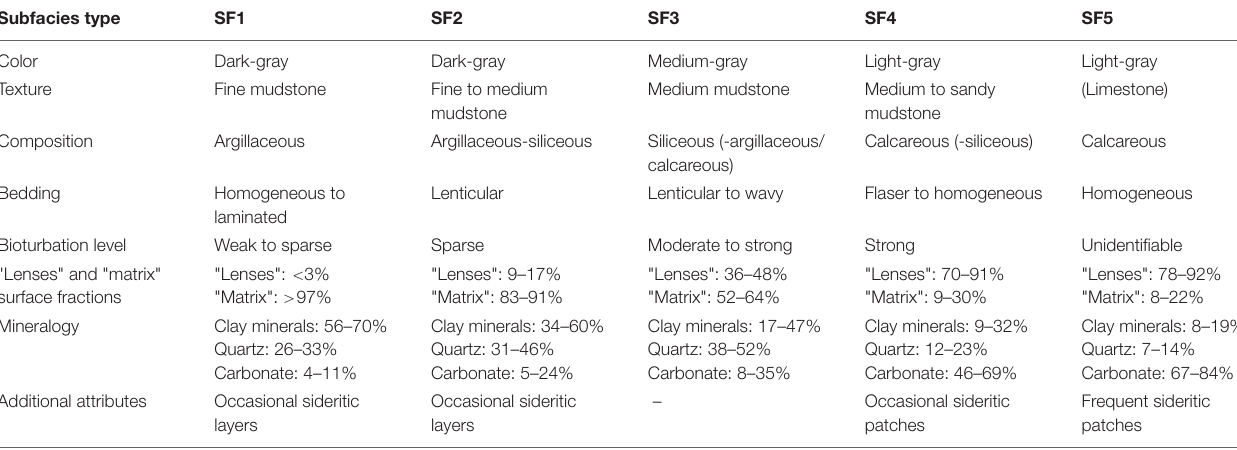
TABLE 1 | Overview of key characteristics of the five OPA subfacies